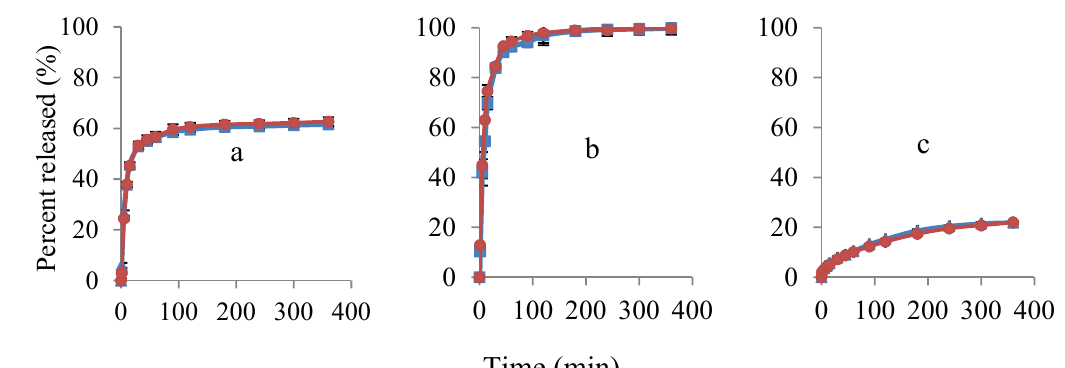
Figure 5. Release profiles of propranolol hydrochloride from solid polymer films with UV ( ■ ) and potentiometric method ( ● ). Ratios of EC:HPC in the polymer component are ( a ) 1:1; ( b ) 0:1 and ( c ) 1:0. Mean ± SD values are shown ( n =